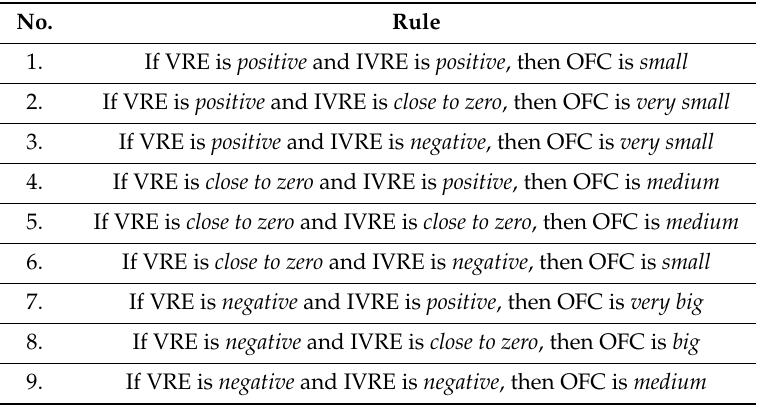
Table 4. Base of rules of fuzzy control